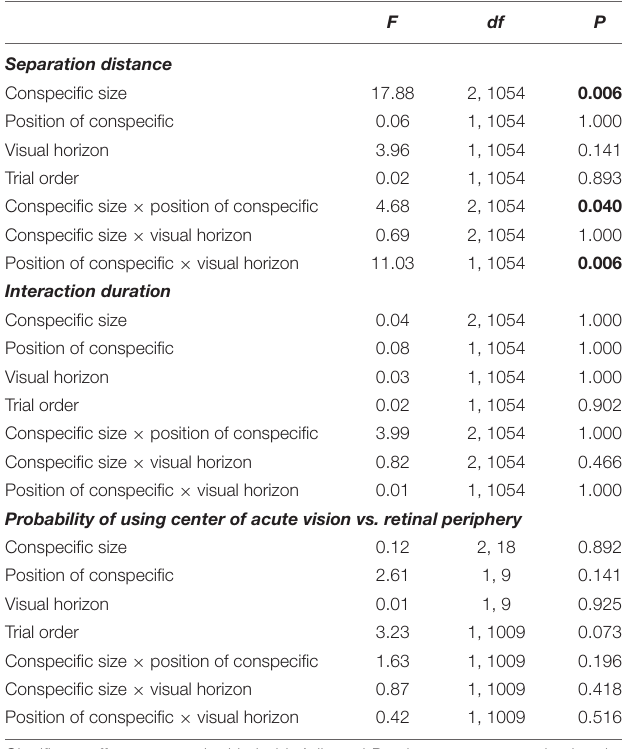
TABLE 1 | Effects of the size of the virtual conspecific, the position of the virtual conspecific in the water column, and the absence/presence of the visual horizon: (a) separation distance, (b) interaction duration, and (c) the probability of viewing the conspecific with the center of acute vision (1) or the retinal periphery (0).